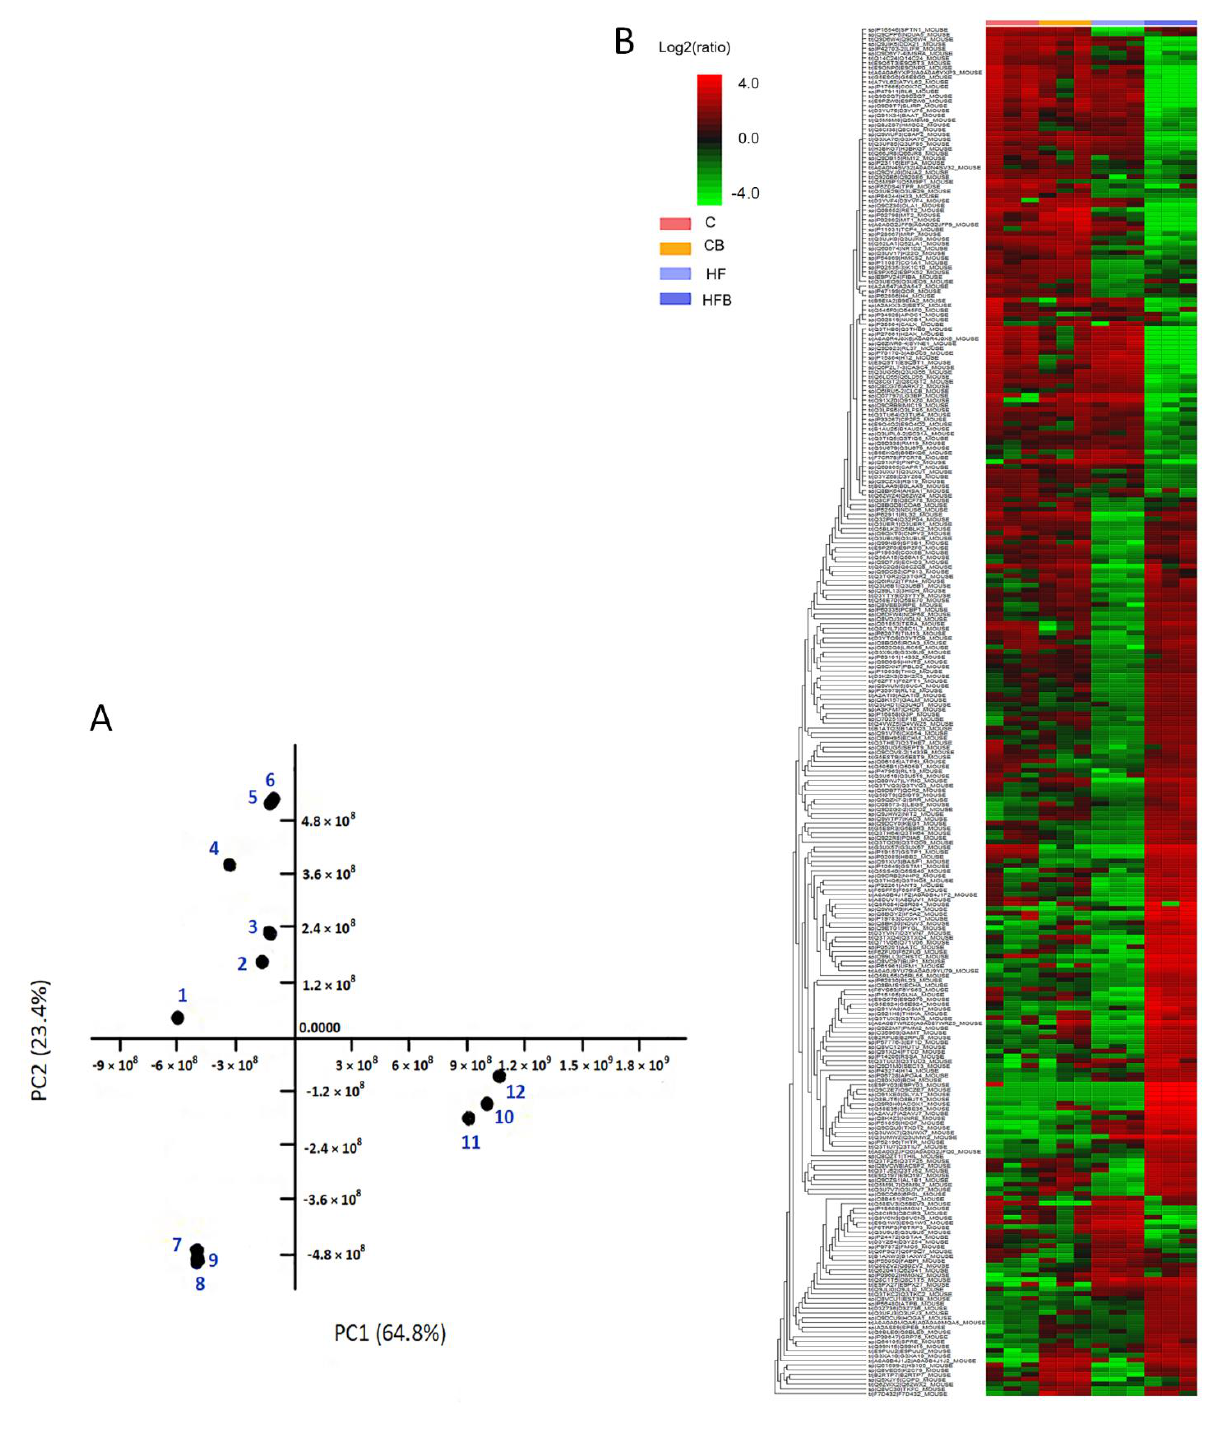
Figure 2. Results of PCA analysis and clustering analysis of liver protein profiles in four treatment groups of mice. ( A ) PCA of non-targeted metabolite profiling in liver using EASY-nLC coupled with Q-Exactive. The points 1, 2 and 3 in the diagram indicate group C; points 4, 5 and 6 indicate group CB; points 7, 8 and 9 indicate HF group and points 10, 11 and 12 indicate group HFB. ( B ) Heat map analysis of differential protein expression in the four groups, red and green indicate high and low concentrations of protein, respectively.